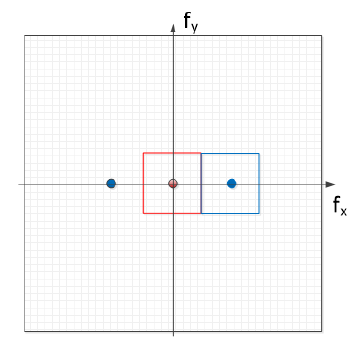
Figure 5. The red and blue marked squares denote the data area that carries the information of S 0 and S 21 In the same way, we can calculate the modulation degree of Figure 2. (a) (b) (c) (d) are the interference patterns when  is Figure 2 (a) – (c) is all 0.71, which satisfies the requirement of 1, 1.1, 1.2 and 1.3 respectively modulation degree >0.5. But The reconstruction errors are 0%, 4.5%, and 9.0%, respectively. To meet the error requirement (e Take Figure 2 (d) as an example, the intensity at x=200 is <10%), the beam splitting ratio should be  <1.22 shown in Figure 3.